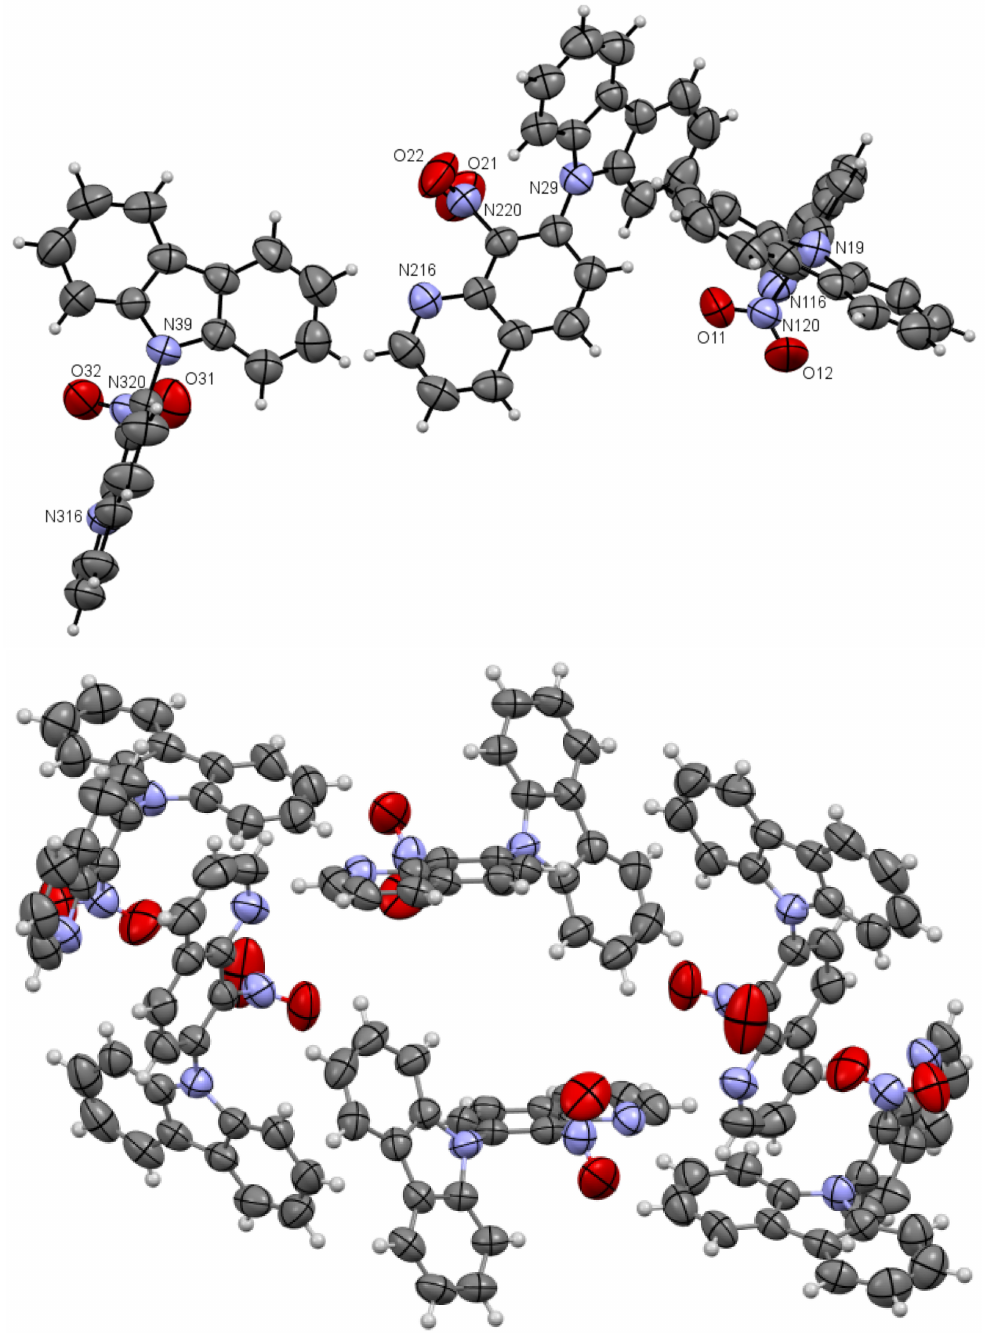
Figure 4. ORTEP drawings of compound 5a with 50% probability ( upper ). ORTEP drawings of packing of compound 5a with 50% probability ( below